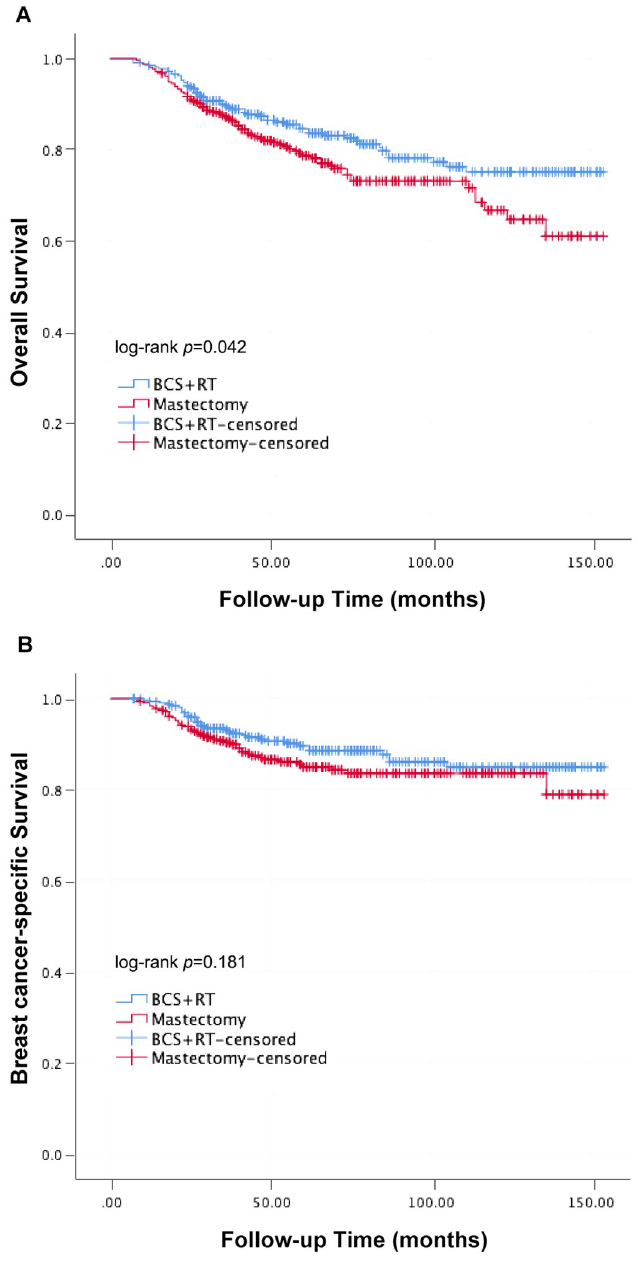
Fig 1. Kaplan-Meier curves of OS (A) and BCSS (B) between BCS+RT and mastectomy groups. (81.12%, 85.63%). These findings indicate a poor prognosis of MBC, consistent with the study findings of Chao et al. [19]. A low positive rate of axillary lymph nodes was observed in our study. 74.27% of the patients in the mastectomy group and 87.93% of the patients in the BCS + RT group had no lymph node metastases, which is in tandem with previous findings (20.72%) [20, 21]. Compared to lymphatic metastasis, MBC is highly associated with blood metastasis; therefore, the rate of lymph node metastasis in MBC patients is low [5].